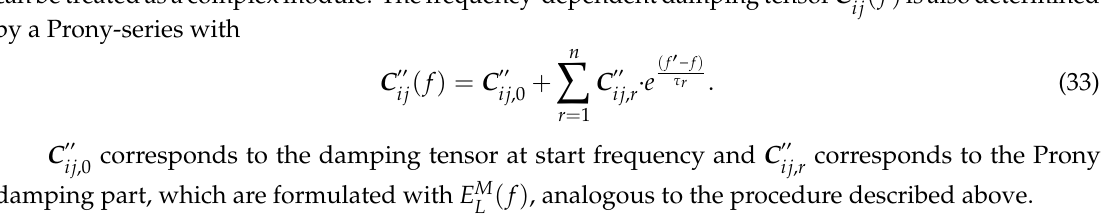
Figure 4. Principle sketch of the used bending vibration test arrangement.